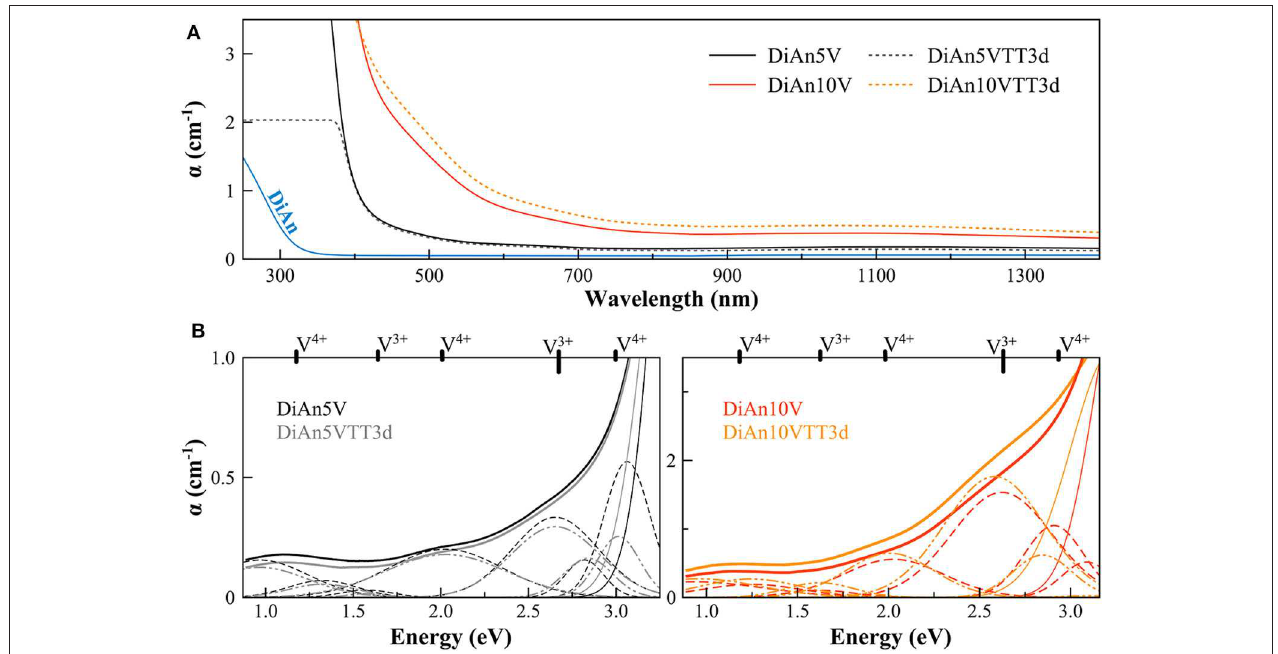
FIGURE 3 | (A) Optical Absorption spectra of pristine and V-doped DiAn glasses, melted in air, or thermally treated (TT). (B) Deconvolution of the optical absorption bands for V-doped DiAn glasses and 3-day thermally treated ones